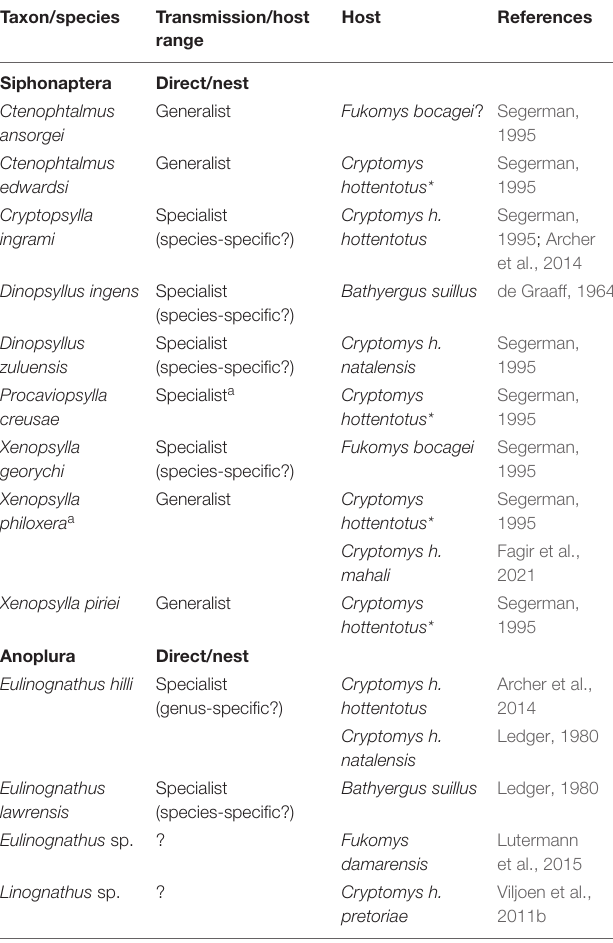
TABLE 1 | Overview of insect parasite species, their mode of transmission and host range reported for the family Bathyergidae to